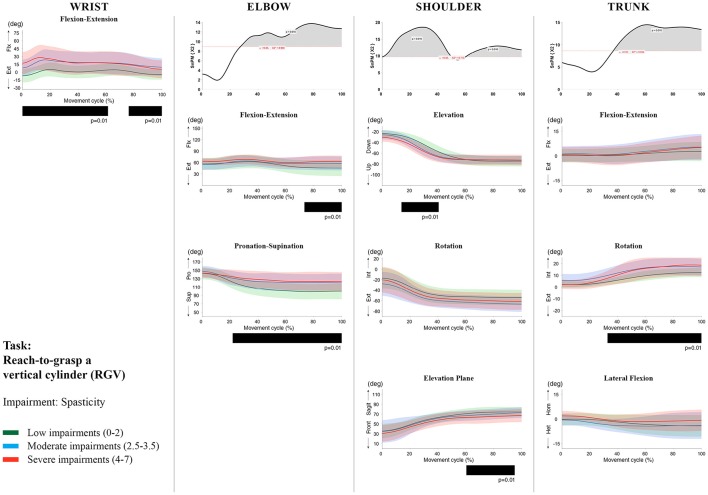
Impact of spasticity on UL movement patterns in children with uCP during the RGV task for all joint angles. Each column corresponds to a joint (from left to right: wrist, elbow, shoulder, and trunk). The top image of each column is the SPM output of the vector field analysis (non-parametric Canonical Correlation Analysis test, except for the wrist, where a non-parametric linear regression was computed). For visualization purposes, kinematic data was grouped according to the level of motor impairments, i.e., spasticity total score: low impairments (score between 0 and 2, i.e., values above percentile 75), moderate impairments (score between 2.5 and 3.5, i.e., values between percentile 25 and 75), and severe impairments (score between 4 and 7, i.e., values below percentile 25). Below, mean (bold line) and standard deviation (translucent area) of the low impairments (green), moderate impairments (blue), and severe impairments (red) of each vector component and the respective post-hoc SPM{t} output. The black bar under each kinematic profile indicates clusters of significant influence of the impairment level on the kinematic variable.